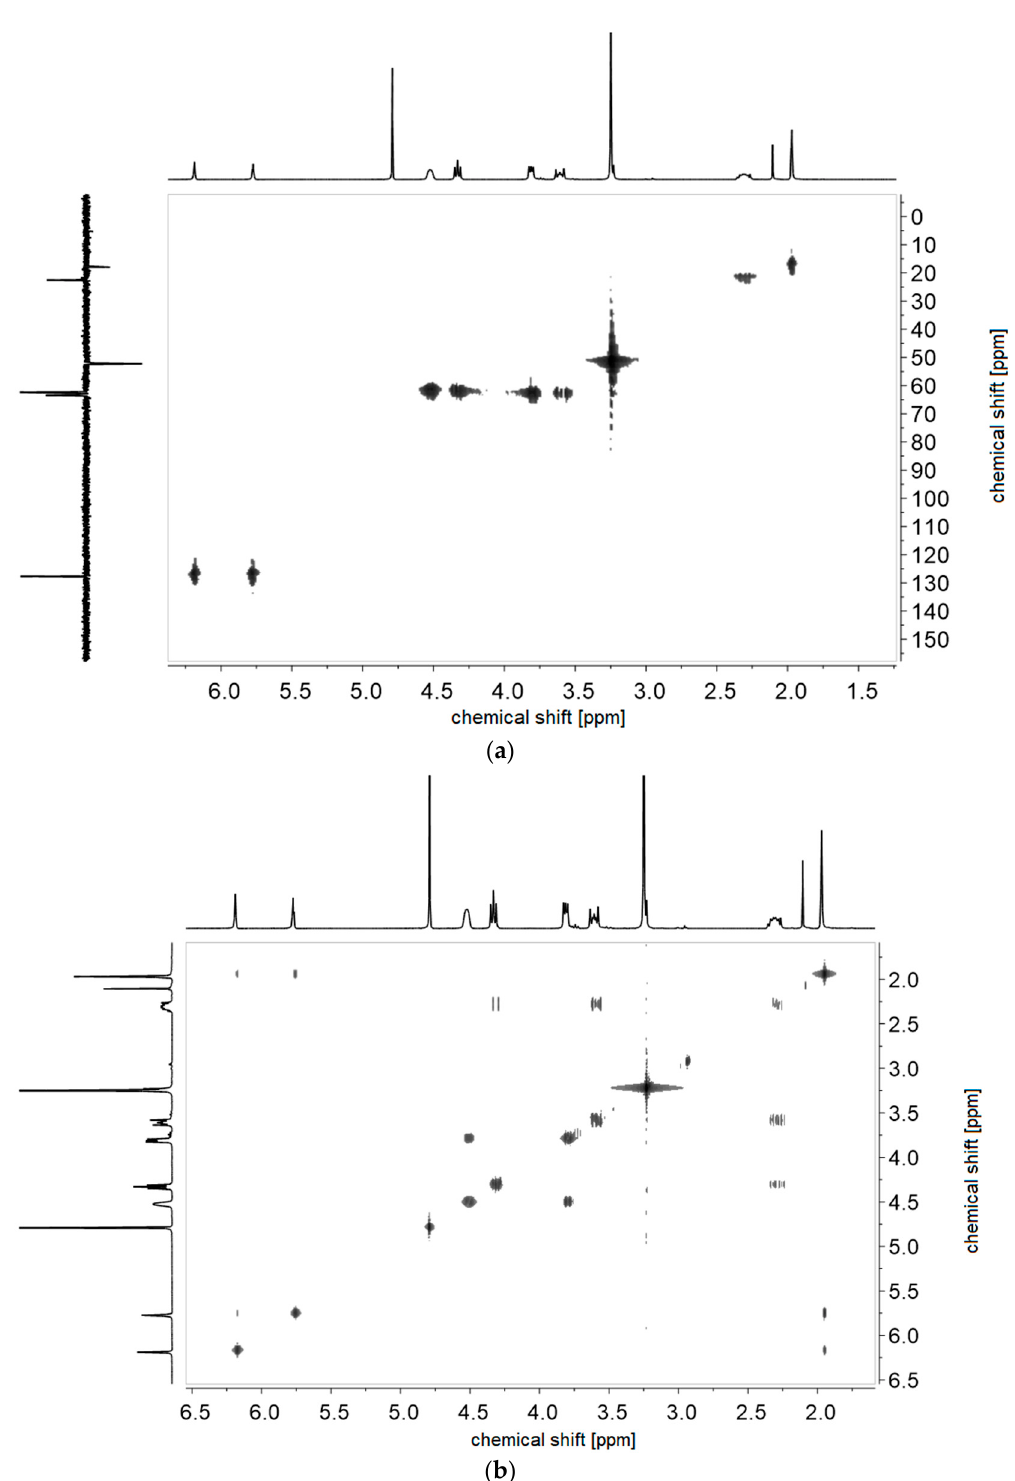
Figure A2. ( a ) 1 H- 1 H-COSY- and ( b ) 1 H- 13 C-HMQC NMR-spectra of monomer of 2c in D 2 O.